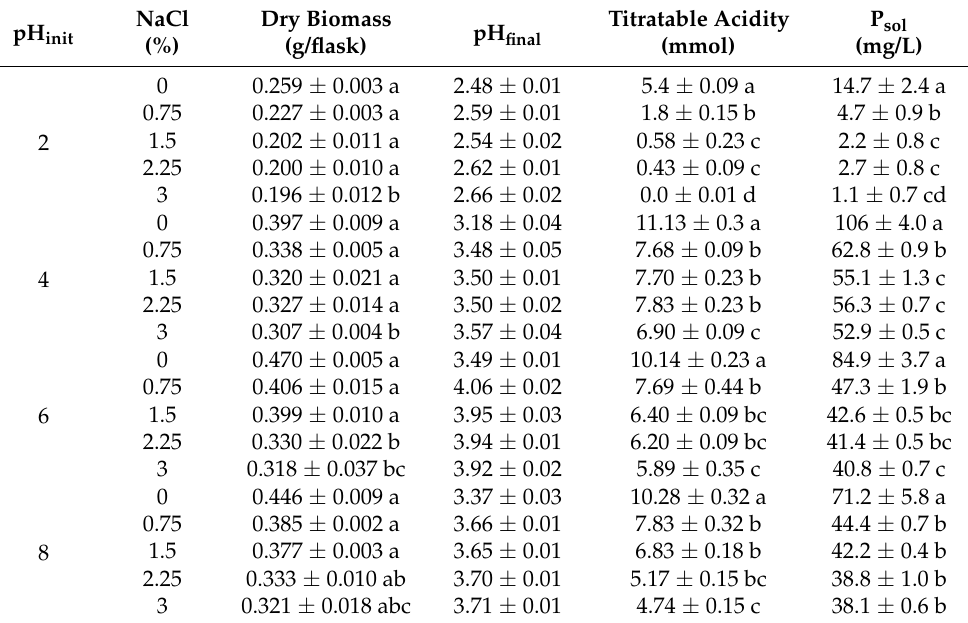
Table 3. Effect of pH and salinity on biomass growth, titratable acidity, and P-solubilizing activity of P. bilaiae in conditions of submerged fermentation. Mean ± standard error ( n = 3) is